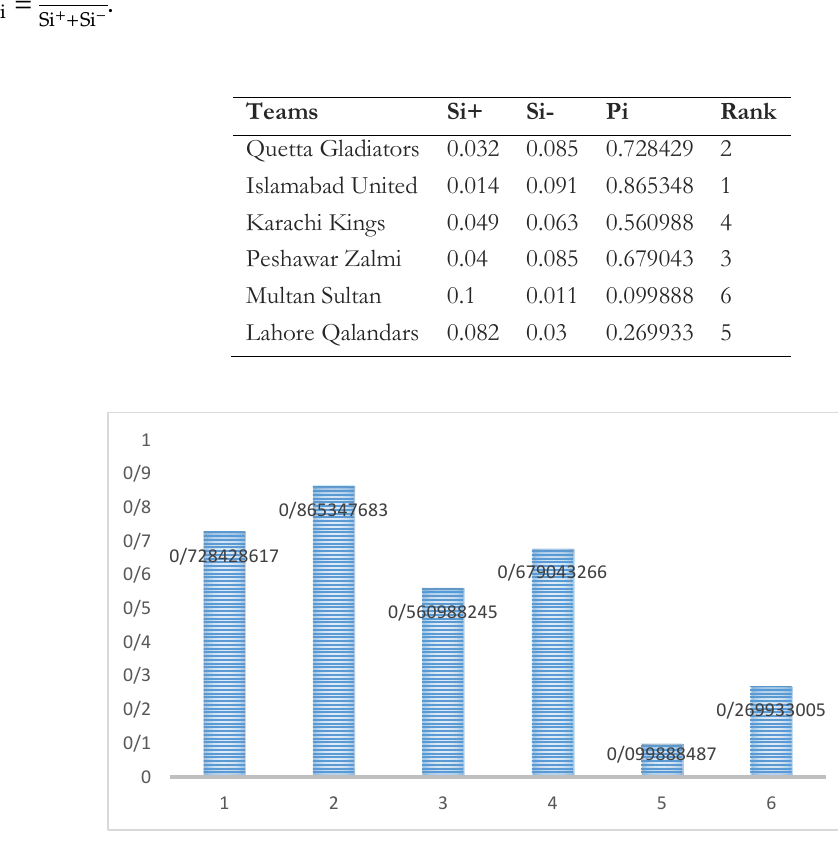
Fig. 3. Graphical representation of the final results against each